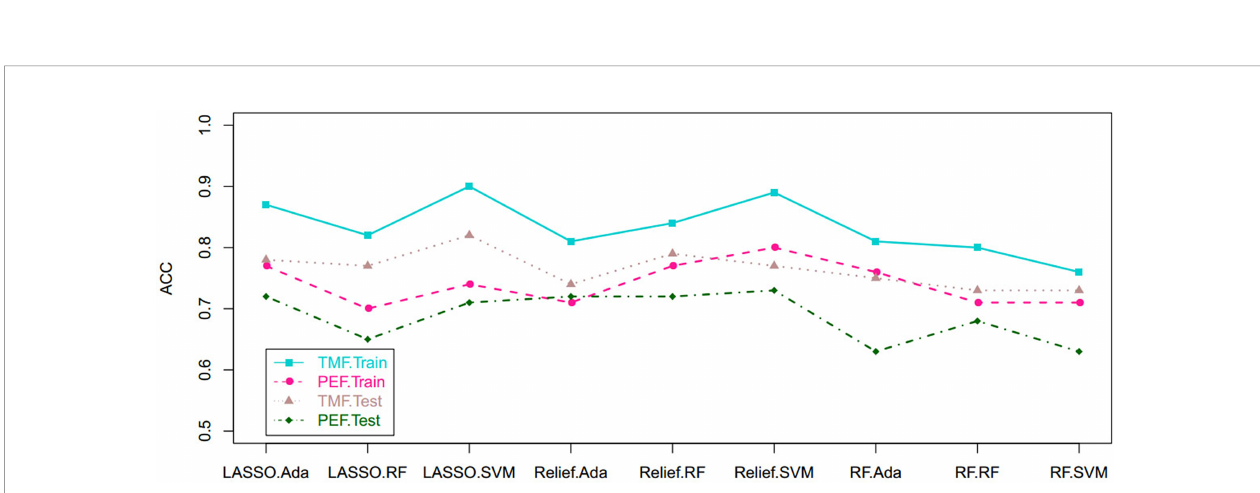
FIGURE 4 | Scatterplots show the ACC of the cross-combination methods based on the features derived from the tumor and peritumoral edema, respectively. ACC, accuracy.